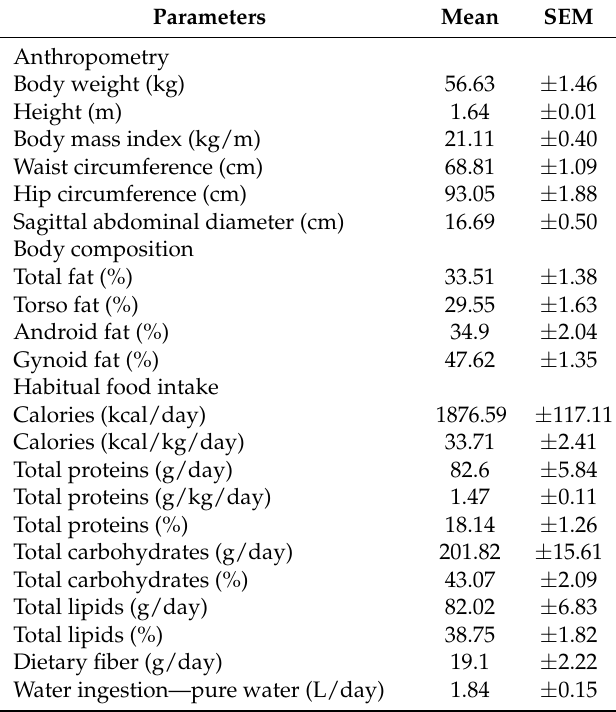
Table 1. Anthropometric, body composition and habitual food intake characteristics.